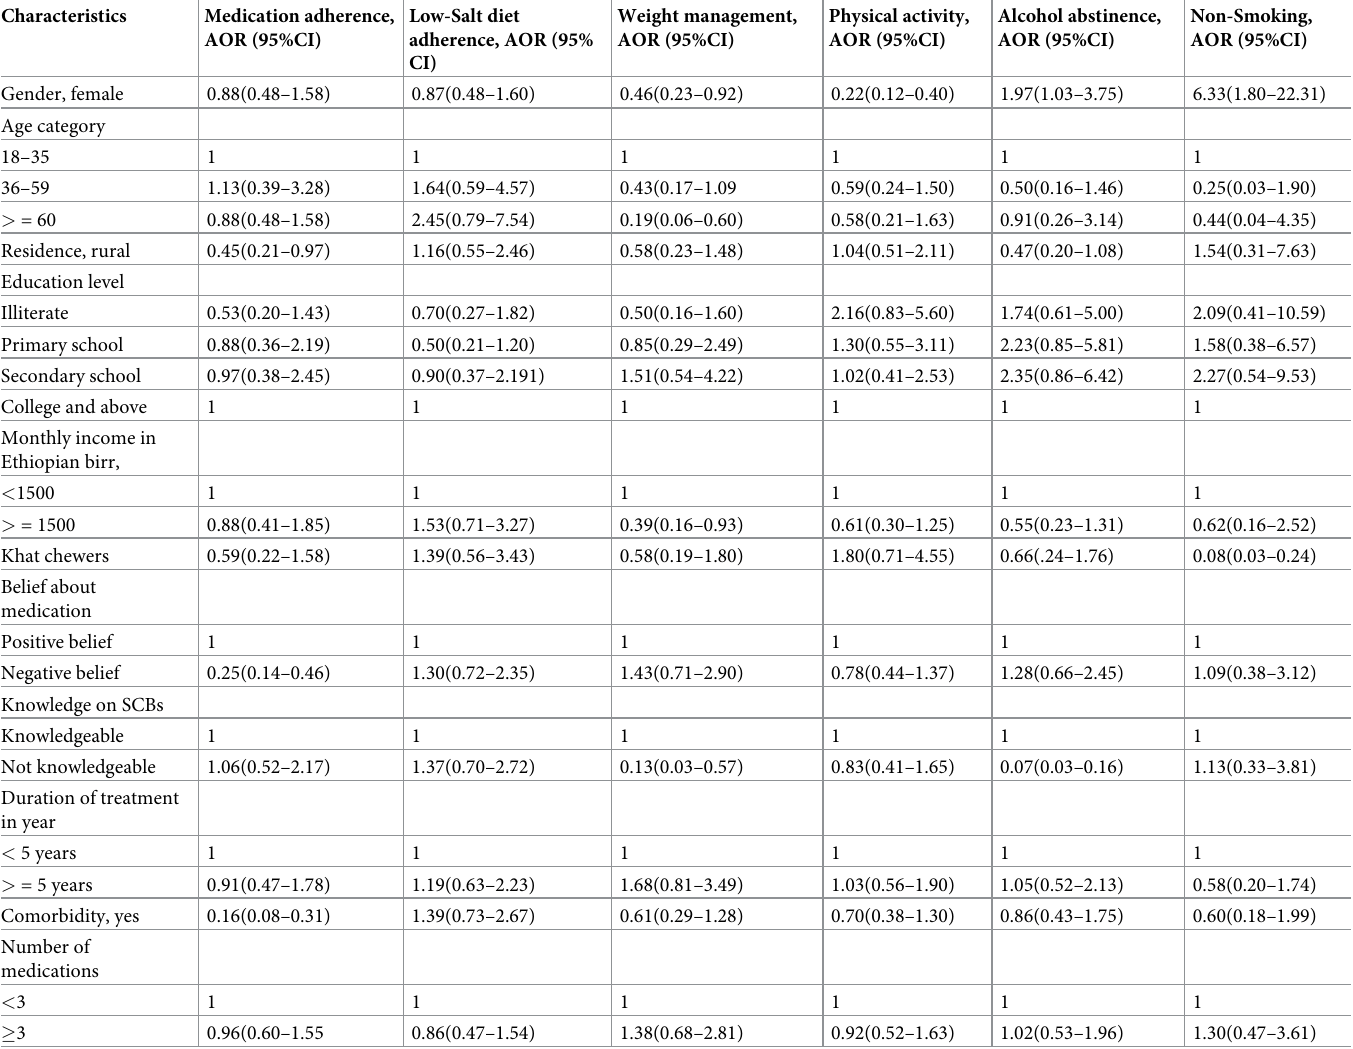
Table 5. Factors associated with adherence to SCBs among hypertensive